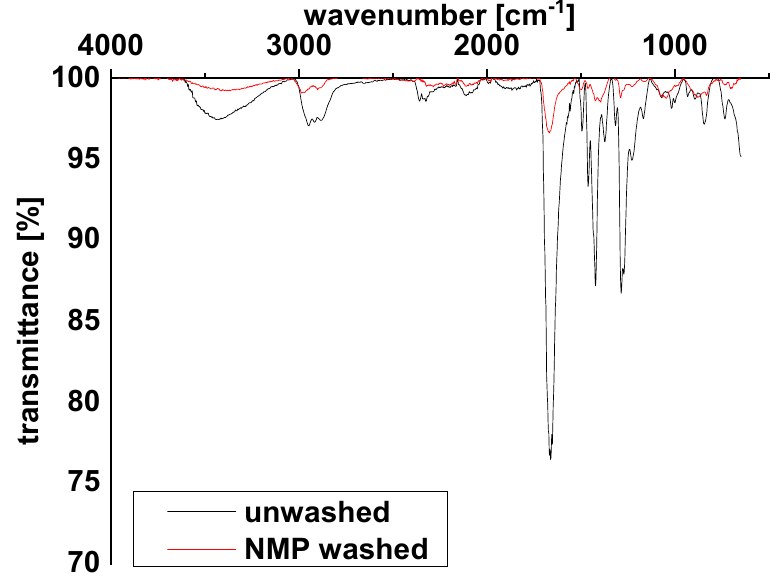
Figure 7. IR spectra of the PVP-modified ZnO nanoparticle before and after extensive washing with